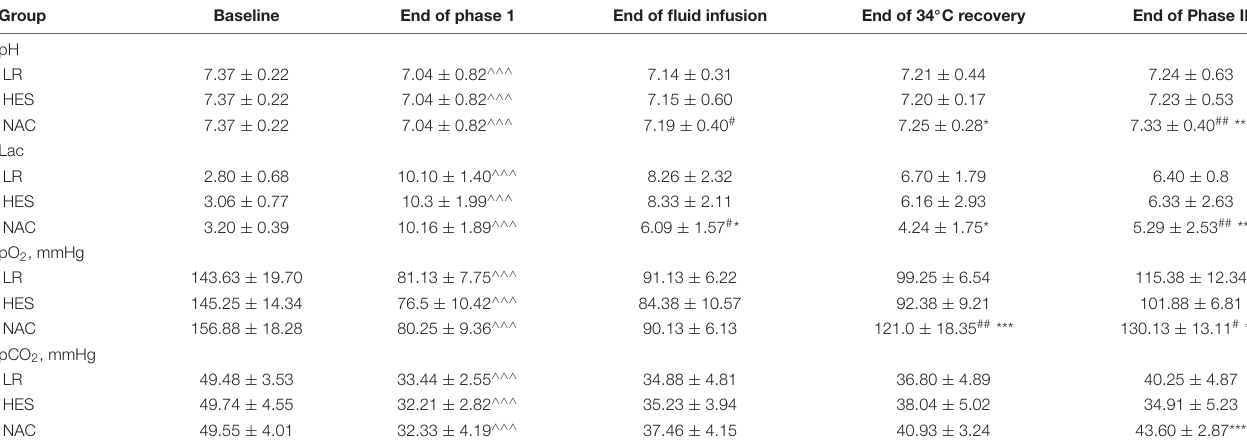
TABLE 1 | Changes of blood gas.